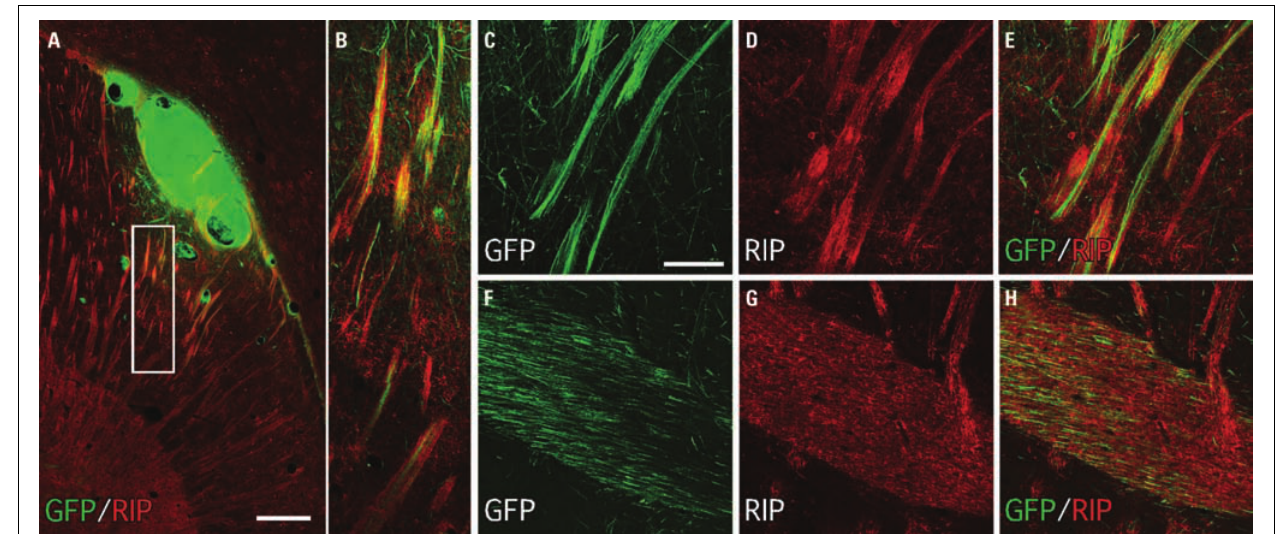
FIGURE 8 | Immunohistochemistry for the oligodendrocyte protein RIP (CNPase) highlights the association of GFP + fibers from transplanted human ES cell-derived neurons with host myelinated fiber bundles. (A,B) A low-power photo-montage shows a GFP + graft placed in the ventral